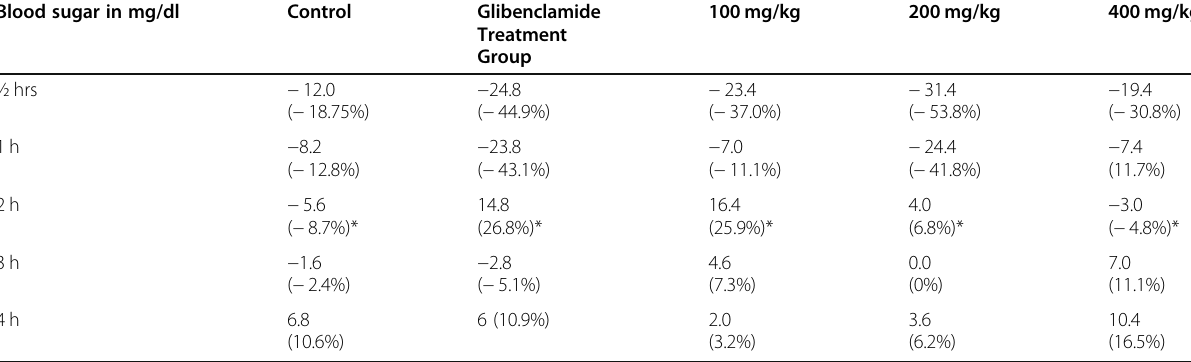
Table 4 A.inermis normal rat ’ s blood glucose difference & Percentage reduction in blood glucose Blood sugar in mg/dl